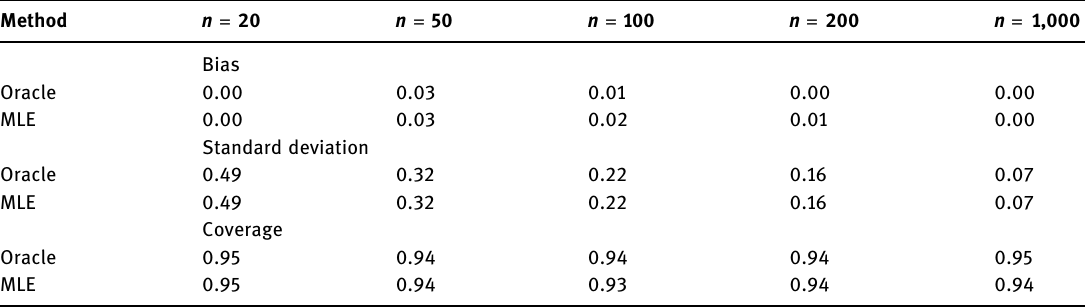
Table A1: Results of simulation scenario 1S comparing oracle GBCEE to MLE GBCEE